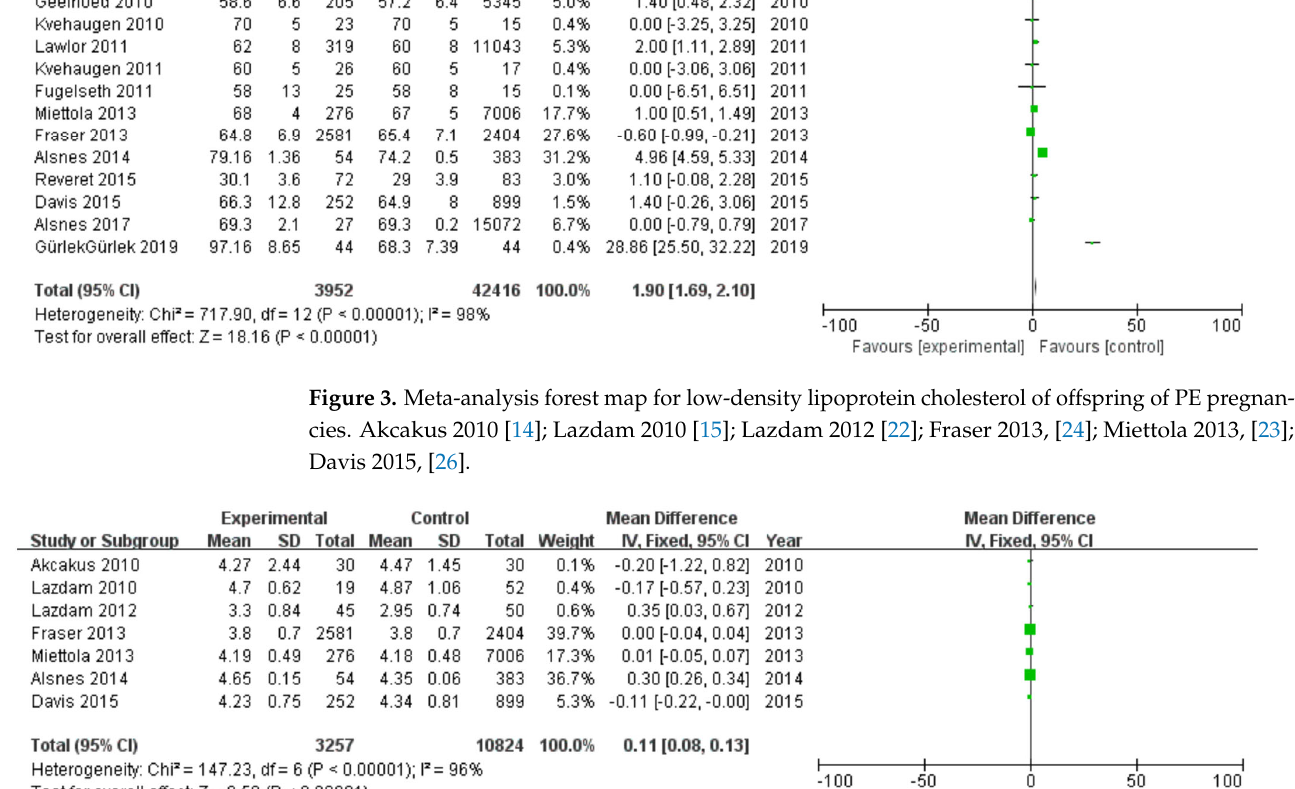
Figure 3. Meta ‐ analysis forest map for diastolic blood pressure of offspring of PE pregnancies.